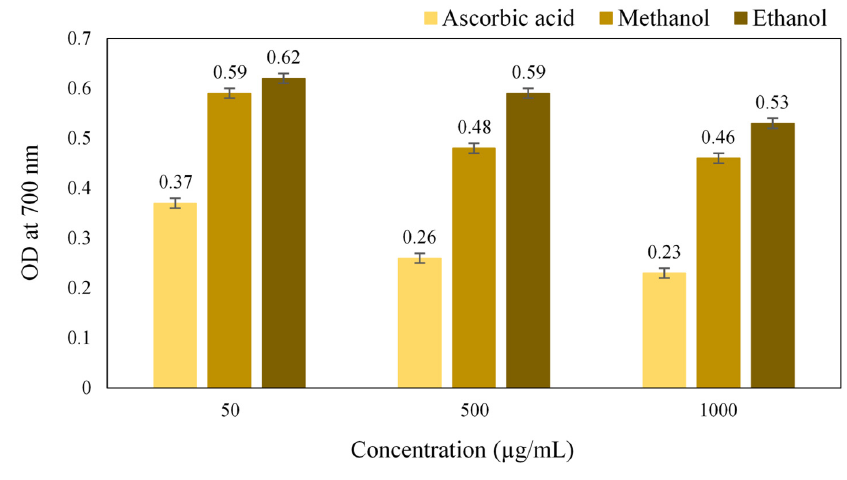
Figure 6. Antioxidant activity of Simarouba glauca extracts (Reducing power activity). Table 8. Anticancer activity of Simarouba glauca extract.